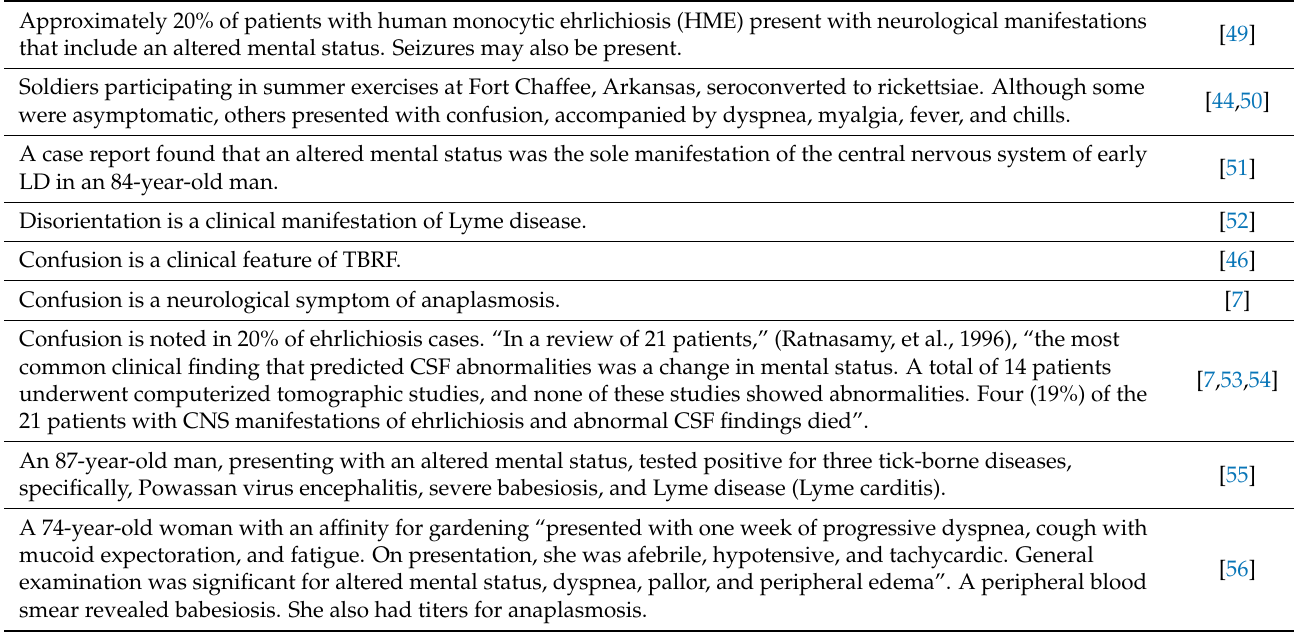
Table 2. Confusion/Altered Mental Status. Altered mental status is found in patients with ehrlichiosis, LD, TBRF, and Powassan, and anaplasmosis, among others. Numerous clinical reports indicated confusion and altered mental status as symptoms of